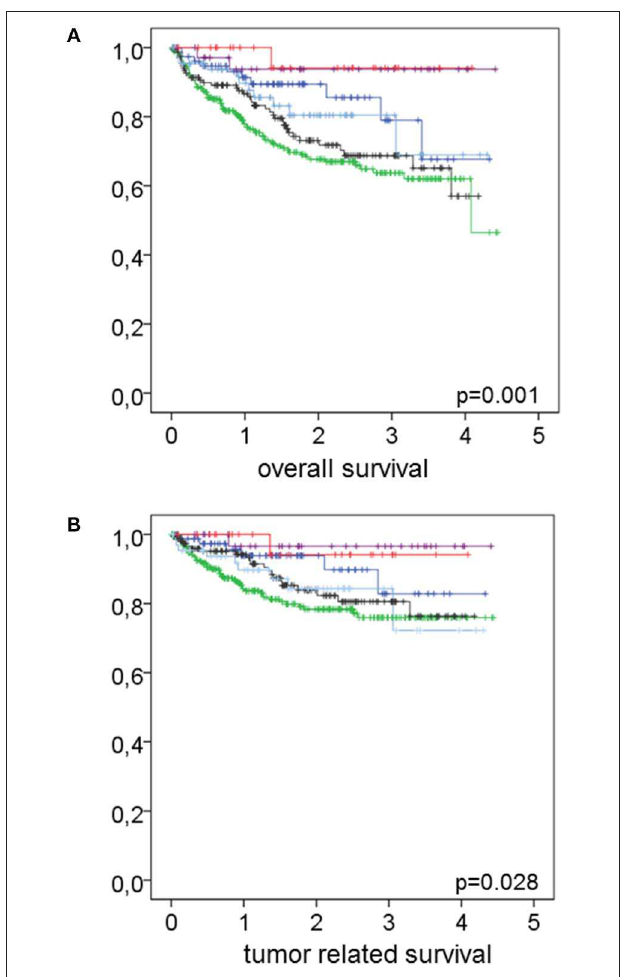
FIGURE 2 | Effect of the combination of smoking habit and co-morbidity on overall and tumor related survival. In (A) overall and in (B) tumor related survival in relation to the combination of smoking habit and co-morbidity is shown. Never smokers without co-morbidities (magenta lines) n = 38 had an overall survival rate of 93.7% and a tumor related survival rate of 96.6%. Former smokers without co-morbidities (red lines) n = 26 had overall and tumor related survival rates of 94.1% each. Active smokers without co-morbidities (light blue lines) n = 67 had an overall survival rate of 80.4% and a tumor related survival rate of 84.3%. Never smokers with co-morbidities (dark blue lines) n = 78 had an overall survival rate of 78.9% and a tumor related survival rate of 82.8%. Former smokers with co-morbidities (black lines) n = 153 had an overall survival rate of 68.7% and a tumor related survival rate of 80.6%. Active smokers with co-morbidities (green lines) n = 280 had an overall survival rate of 63.7% and a tumor related survival rate of 75.9%. Log rank test revealed p = 0.001 and 0.028 for overall and tumor related survival,